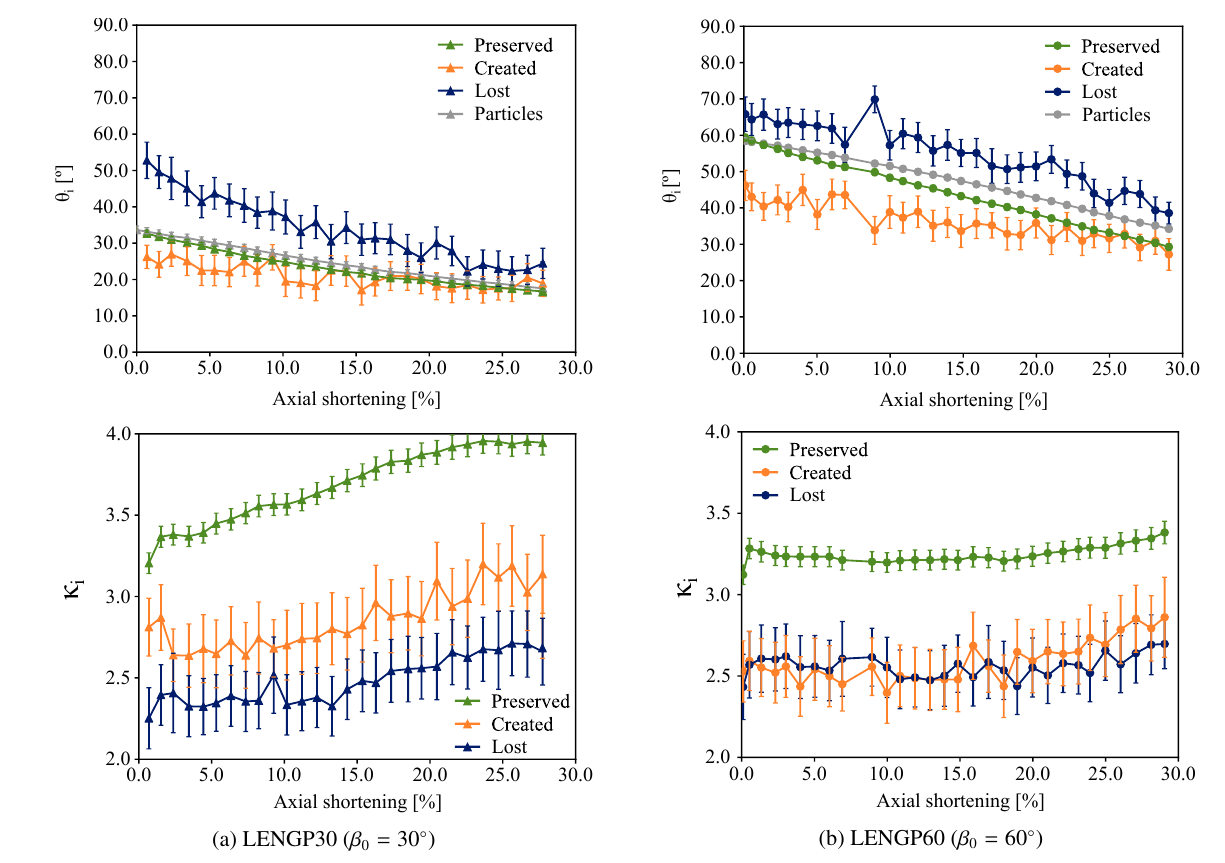
Figure 3: Evolution of contact subset orientation (top) and respective concentration (bottom) with specimen shortening